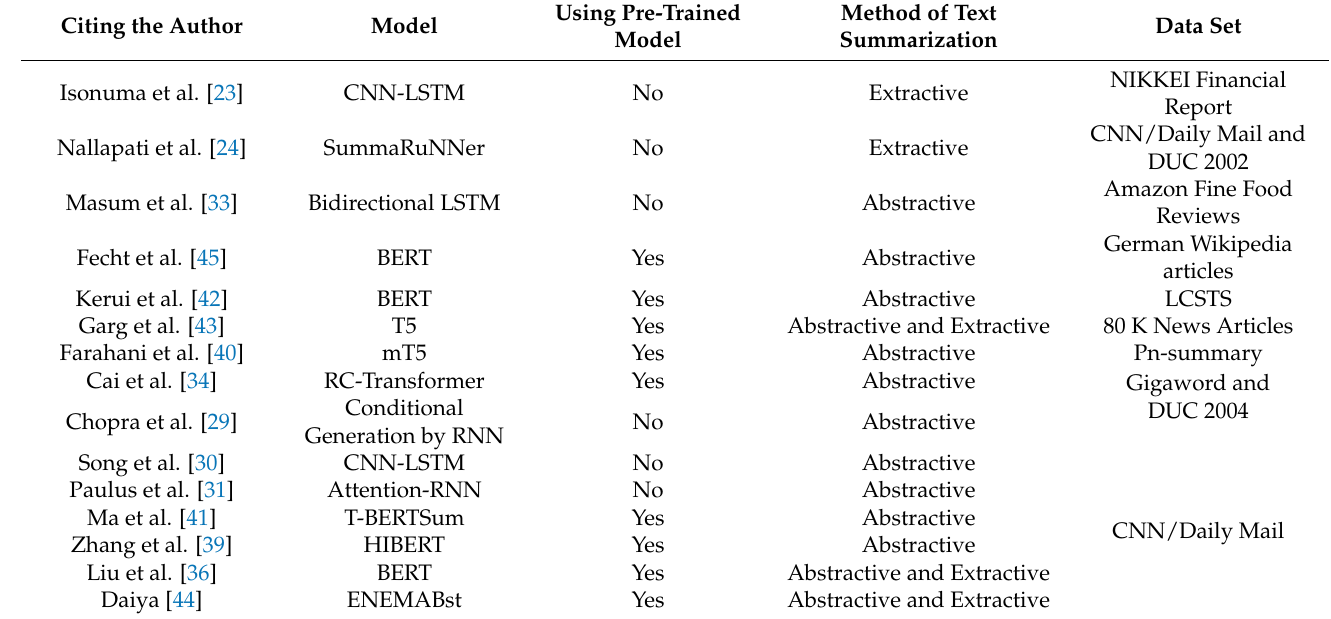
Table 1. Related work of automated text